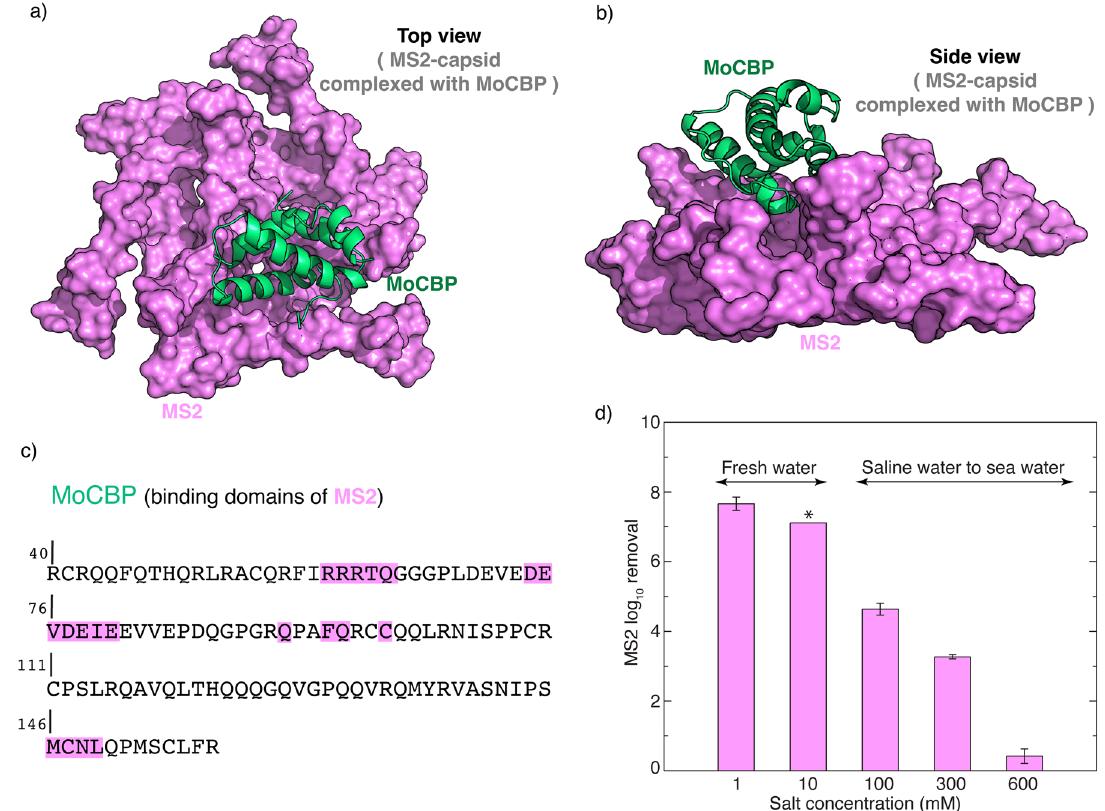
Fig. 5 Flexible molecular docking simulations and column experiments at various salt concentrations indicate that the primary mechanism of removal in MO -cotton fi lters is based on electrostatic interactions. a , b The top view and the side view of the favorable docking position observed from the fl exible molecular docking simulations between MS2 capsid (pink) and MoCBP (green). c The amino acid residues that constitute the interaction interface of MS2 are overlaid onto the primary sequence of MoCBP. d Experimental log 10 removal of 10 8 PFU mL − 1 MS2 bacteriophage in fl uent using MO -cotton fi lters at a fl owrate of 2 mL min − 1 and various salt concentrations in the range of 1 – 600 mM NaCl as the dispersant show the removal ef fi ciency achieved decreases with increase in salt concentration. The log 10 removal ef fi ciency is based on the ef fl uent sample collected at 50 mL ef fl uent. *Indicates that the ef fl uent concentration was below the limit of detection which indicates that the actual removal, in this case, could be higher than the reported values. All the error bars shown in the fi gure represent the standard deviation calculated from three independent